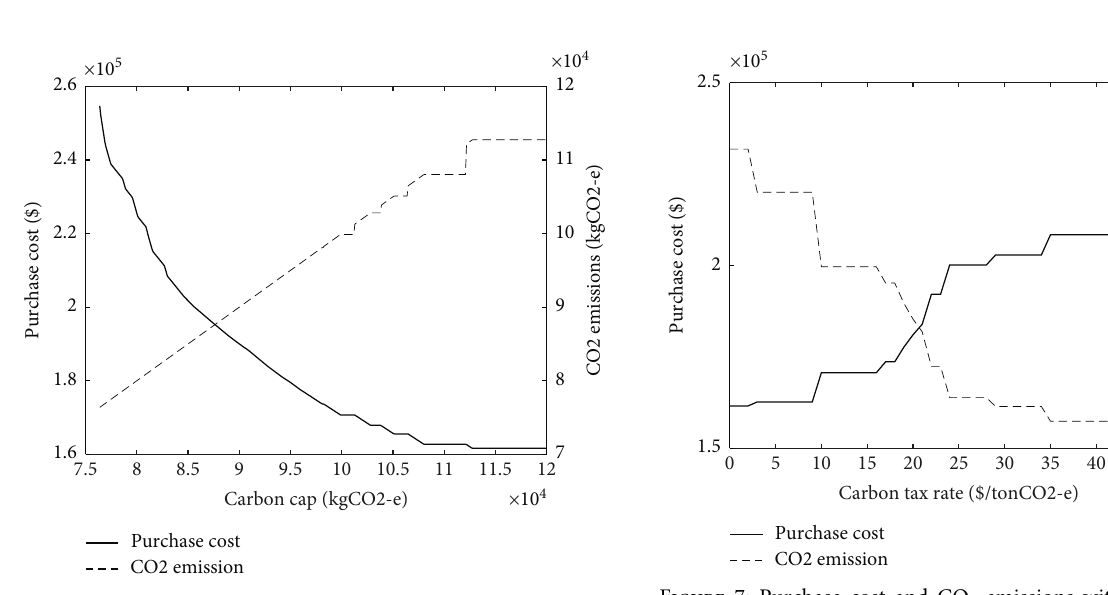
2 emissions with respect to the